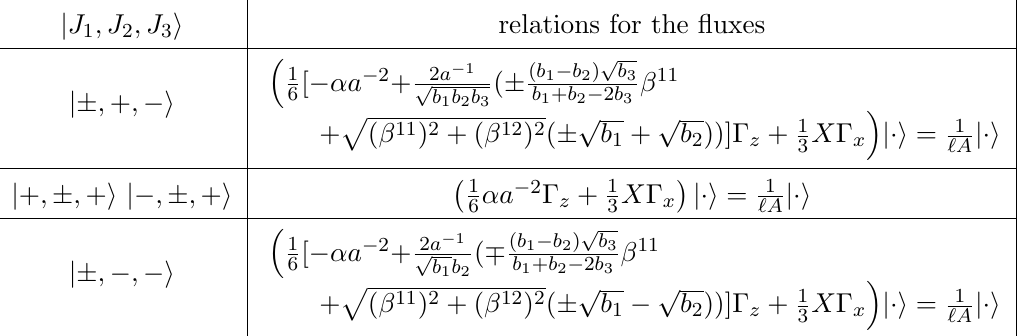
Table 12 . Decomposition of (4.98) KSE into